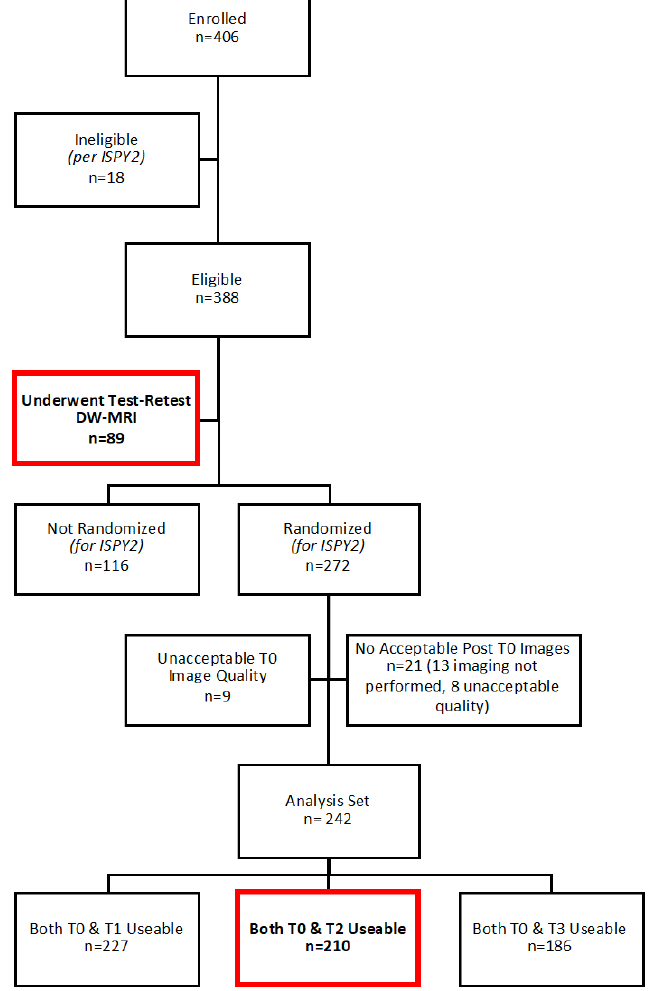
Figure 1. Consolidated Standards of Reporting Trials diagram summarizing ACRIN 6698